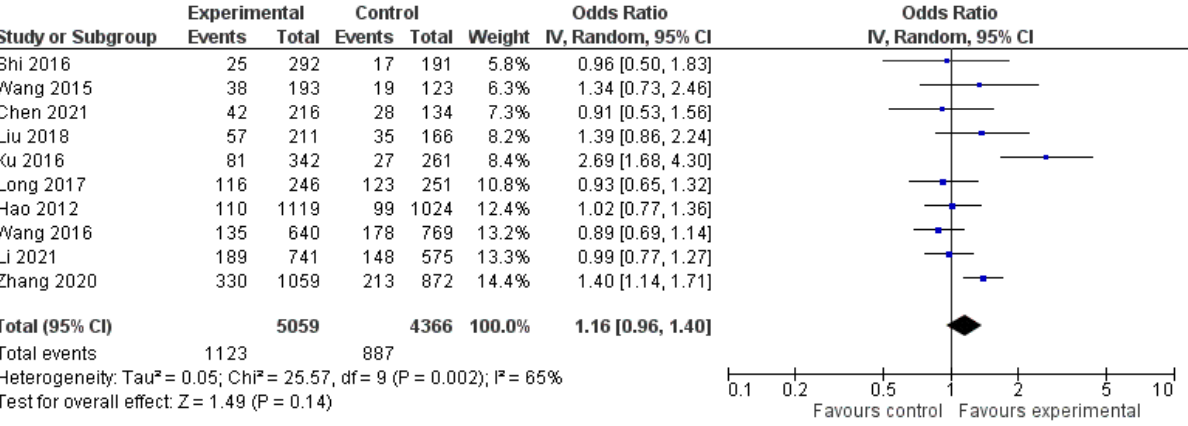
Figure 2. Forest plot of the total number of lymph nodes harvested.